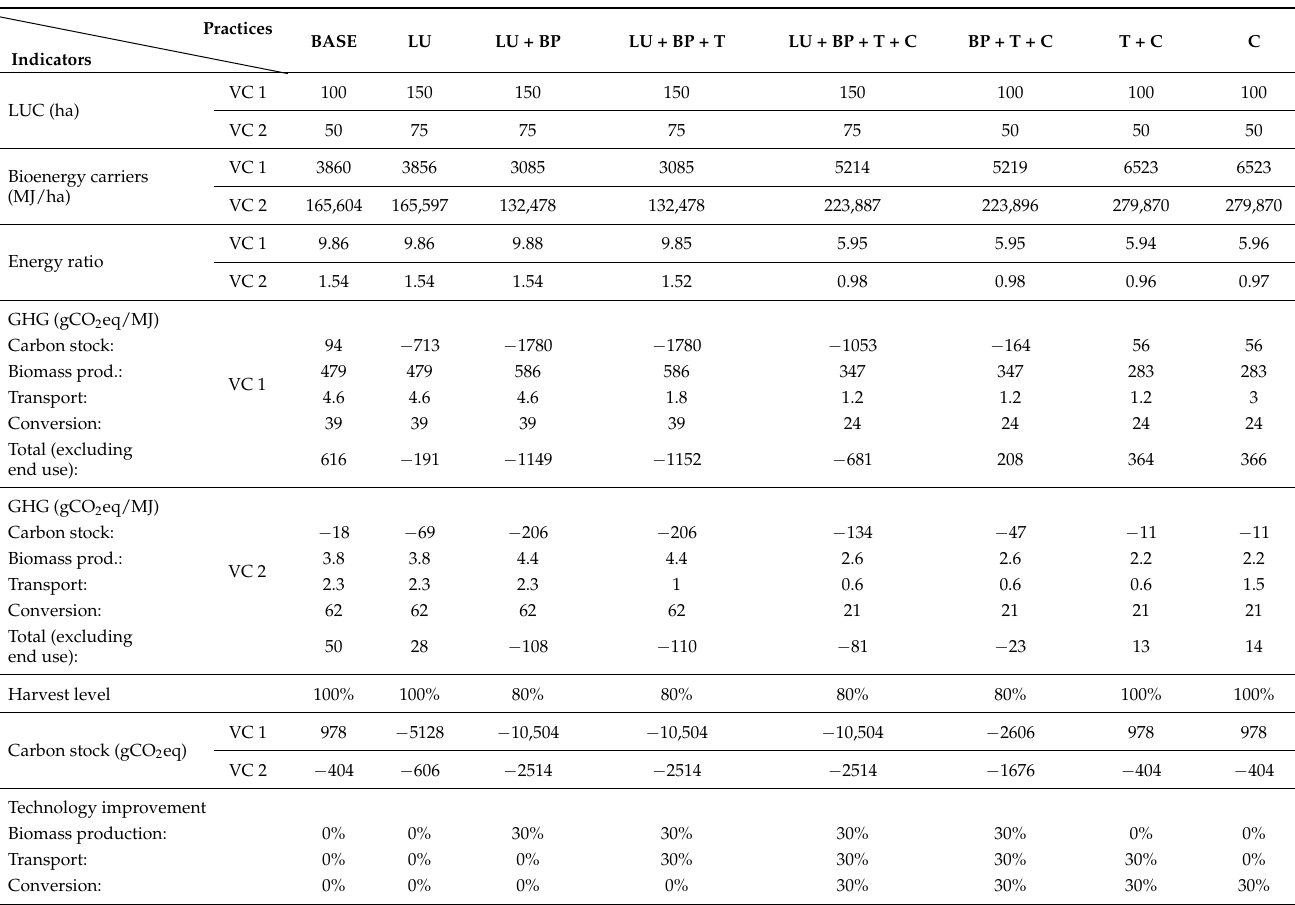
Table 3. Indicator-based impacts of value chain practices for 7 scenarios ( BASE: no practices imple- mented; LU: practices implemented at the land use stage; BP: practices implemented at the biomass production stage; T: practices implemented at the transport stage; C: practices implemented at the conversion stage